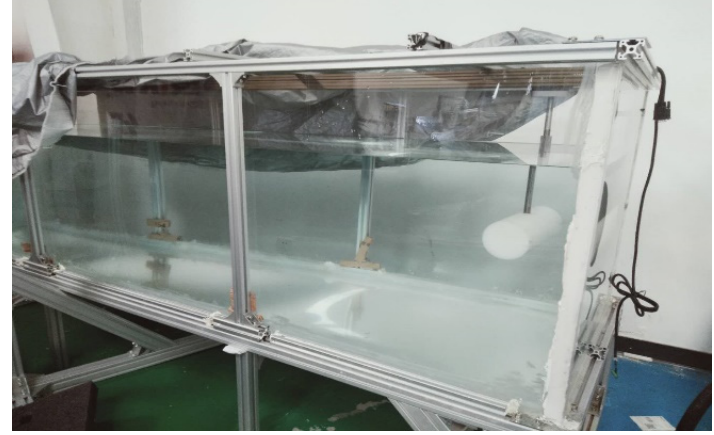
Figure 3. The experimental environment for the PIV experiment.